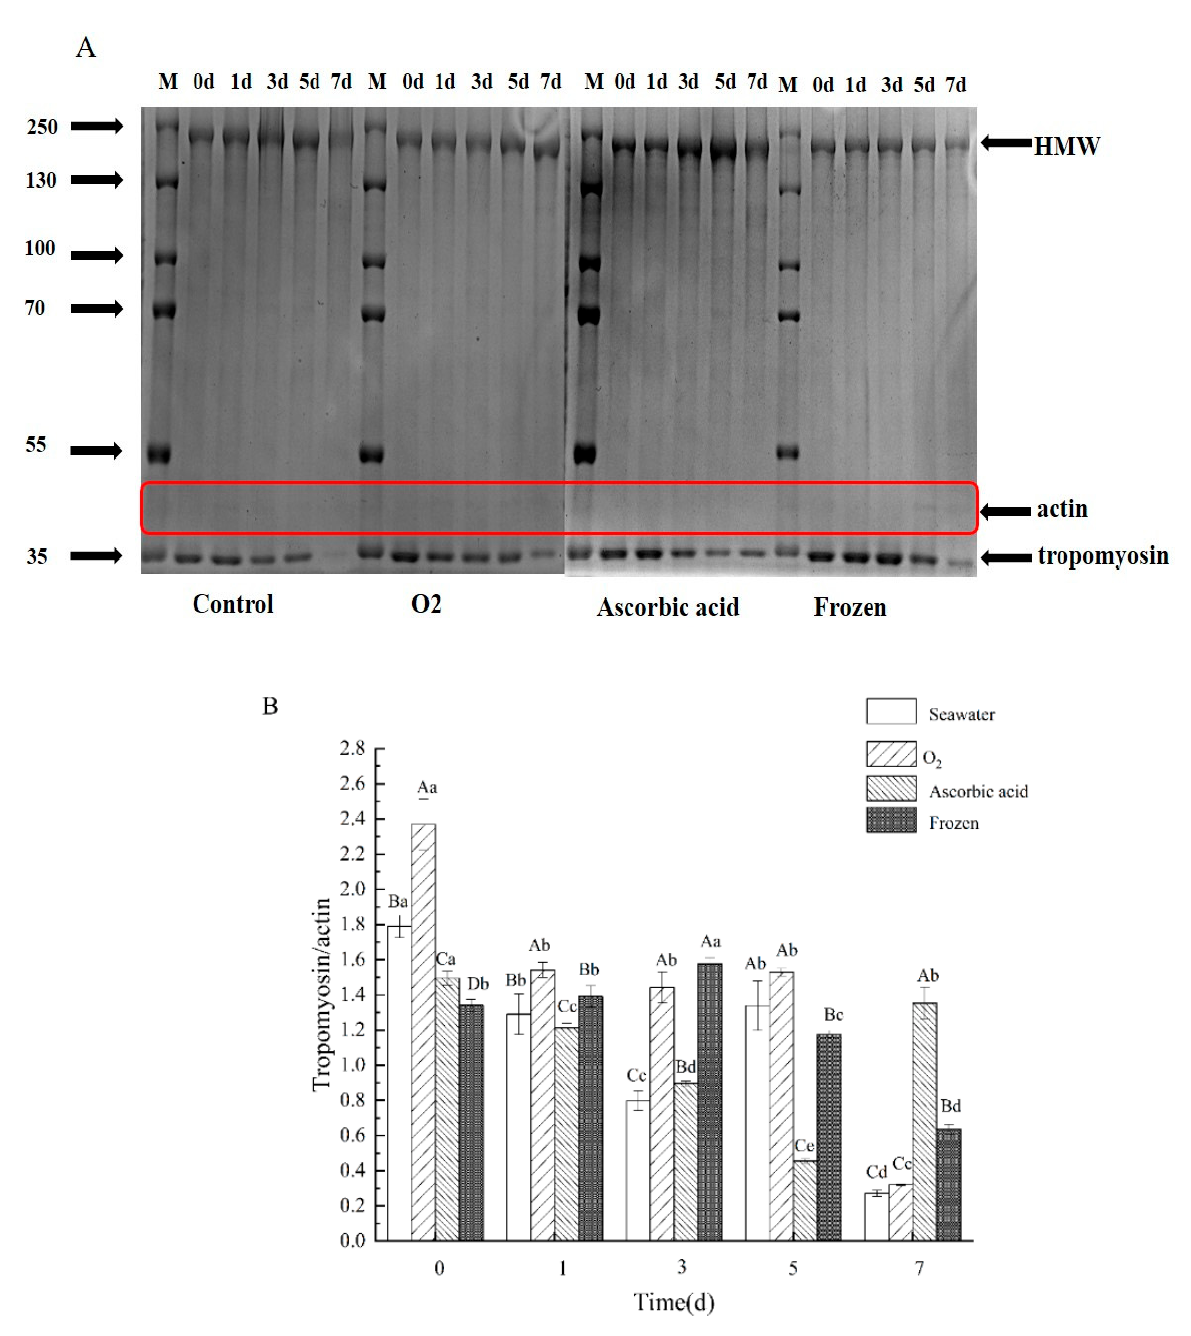
Figure 7. SDS-PAGE (5% Stacking gel and 8% separated gel) analysis of stored sea cucumbers protein by different treatments. ( A ) Electrophoretic diagram of SDS-PAGE and ( B ) quantitative analysis of electrophoresis. Relative expression = tropomyosin/ actin. Dates are presented as mean ± SD ( n = 3). Different capital letters indicate significant differences in the average between groups. Different lowercase letters indicate significant differences in the average value within each group ( p < 0.05).